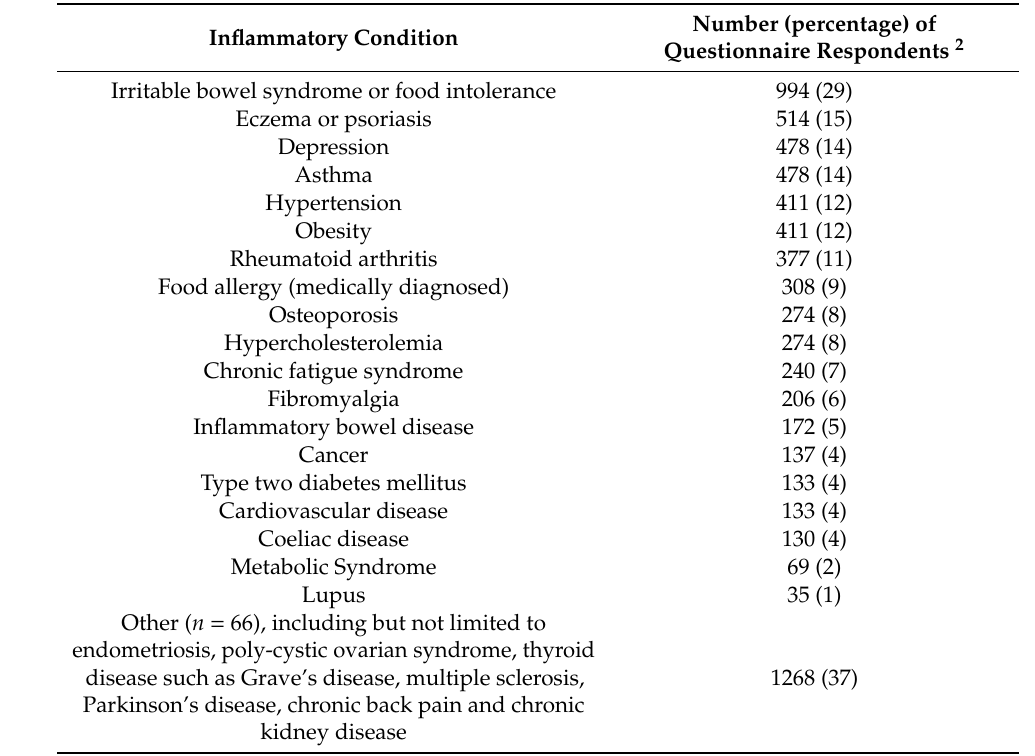
Table 2. Inflammatory conditions reported by learners 1